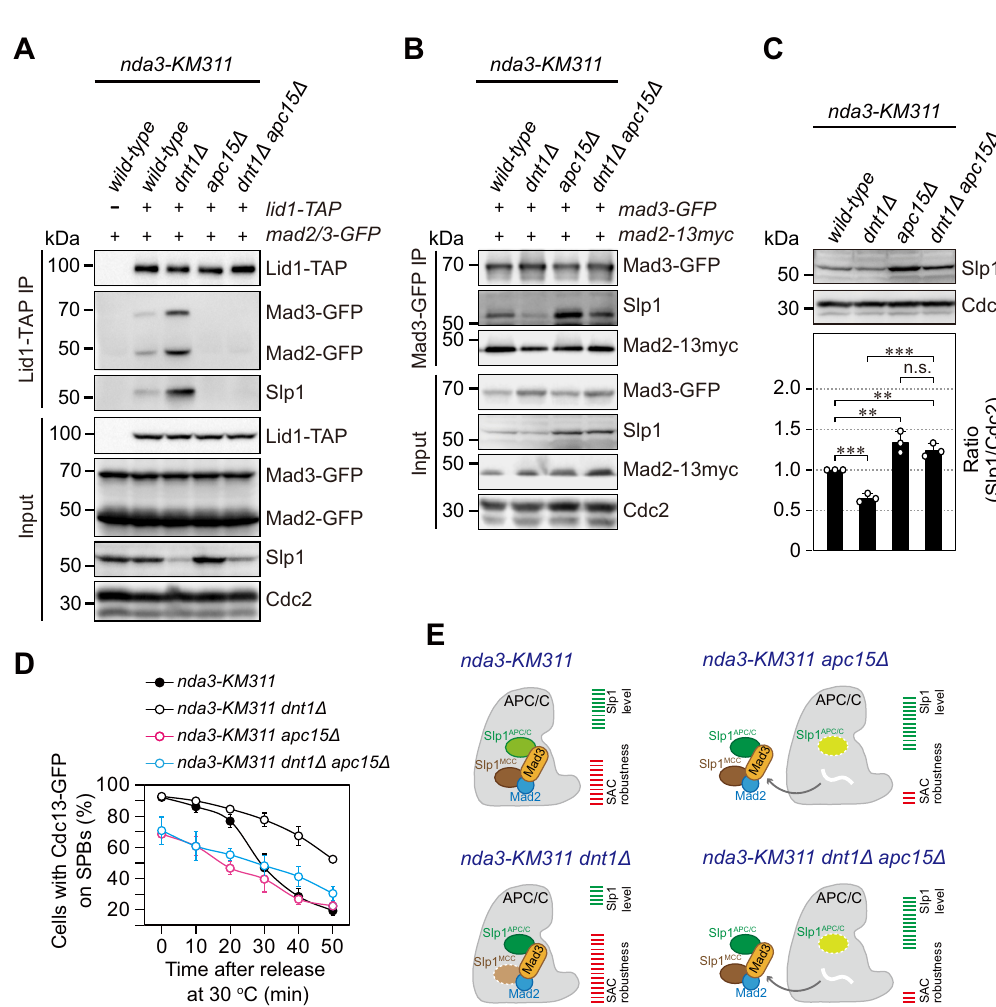
Fig 4. apc15 Δ reverses enhanced MCC-APC/C association and lowered Slp1 Cdc20 abundance in dnt1 Δ cells. ( A ) apc15 Δ abolishes the elevated binding of MCC to APC/C in dnt1 Δ cells. The association of Mad2, Mad3 and Slp1 Cdc20 to Apc4/Lid1 was assessed by immunoprecipitation of Apc4/Lid1-TAP in checkpoint-arrested cells as in Fig 2F. Note that more Mad2, Mad3 and Slp1 Cdc20 was co-immunoprecipitated in dnt1 Δ cells compared to wild-type cells, although the amount of Slp1 Cdc20 was less abundant in dnt1 Δ cells than that in wild-type cells. Results shown are the representative of three independent experiments. ( B ) apc15 Δ restores the amount of Slp1 Cdc20 bound to MCC in dnt1 Δ cells. The assembly of MCC was assessed by immunoprecipitation of Mad3-GFP in checkpoint-arrested cells as in ( A ). Note that less Slp1 Cdc20 was co- immunoprecipitated in dnt1 Δ cells compared to wild-type cells. Results shown are the representative of three independent experiments. ( C ) apc15 Δ restores the abundance of Slp1 Cdc20 in dnt1 Δ cells. Strains with indicated genotypes were grown and treated as in ( A ) to enrich checkpoint-arrested cells. Slp1 Cdc20 levels were quantified with the relative ratio between Slp1 Cdc20 and Cdc2 in wild-type strain set as 1.0. The experiments were repeated 3 times and the mean value for each sample was calculated as in Fig 3D. Error bars correspond to standard deviation. ��� , p < 0.001; �� , p < 0.01; n.s., not significant. ( D ) apc15 Δ suppresses the delayed APC/C activation defect in dnt1 Δ cells. Cells were synchronized by HU and then arrested at 18˚C for 6 hours before being released at 30˚C. The percentage of cells with Cdc13-GFP on SPBs was assessed at each time point as in Fig 2C. ( E ) Schematic summary of data from (A-D). White wavy lines depict the absence of Apc15. Lighter or darker shading depicts lower or higher levels of Slp1 Cdc20 present in MCC or APC/C in mutant cells compared to wild-type